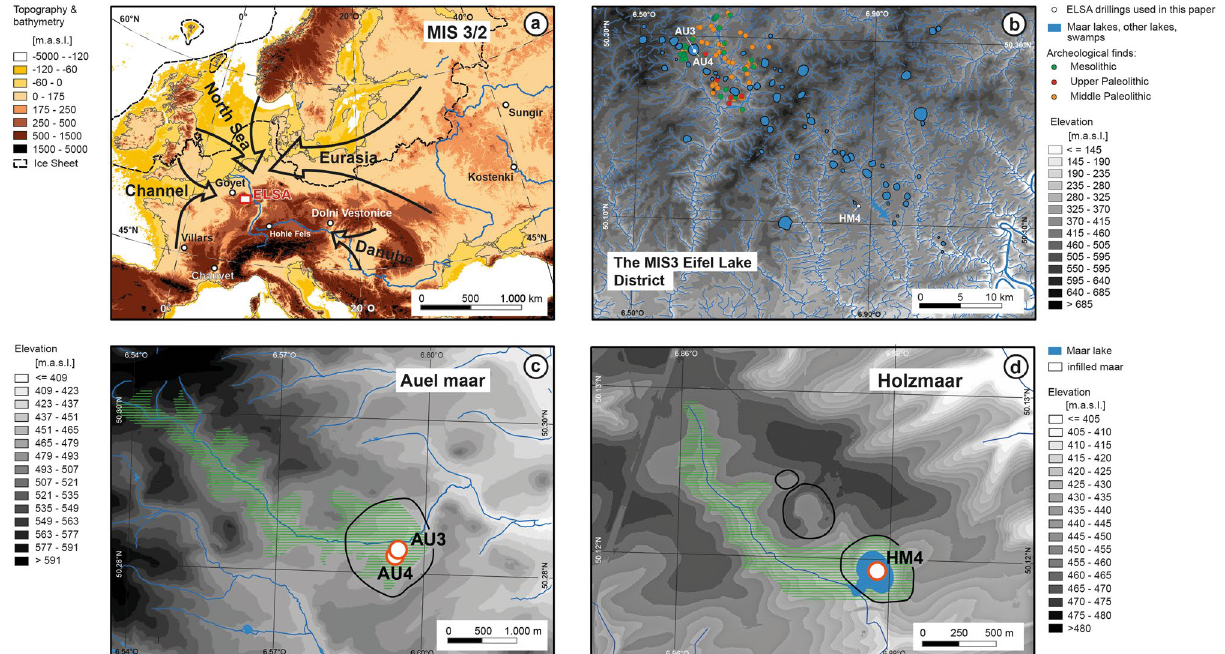
Figure 1. Maps, ( a ) Digital Elevation of Europe with potential corridors for MF migration, ( b ) Maar lakes during the MIS3, ( c ) catchment of the infilled maar lake at Auel, ( d ) catchment of the Holzmaar lake. The maps were made with QGIS 3.16 (https:// qgis. org) from ETOPO1 1 Arc-Minute Global Relief Model (NOAA National Geophysical Data Center, 2009), a model of Earth’s surface that integrates land topography and ocean